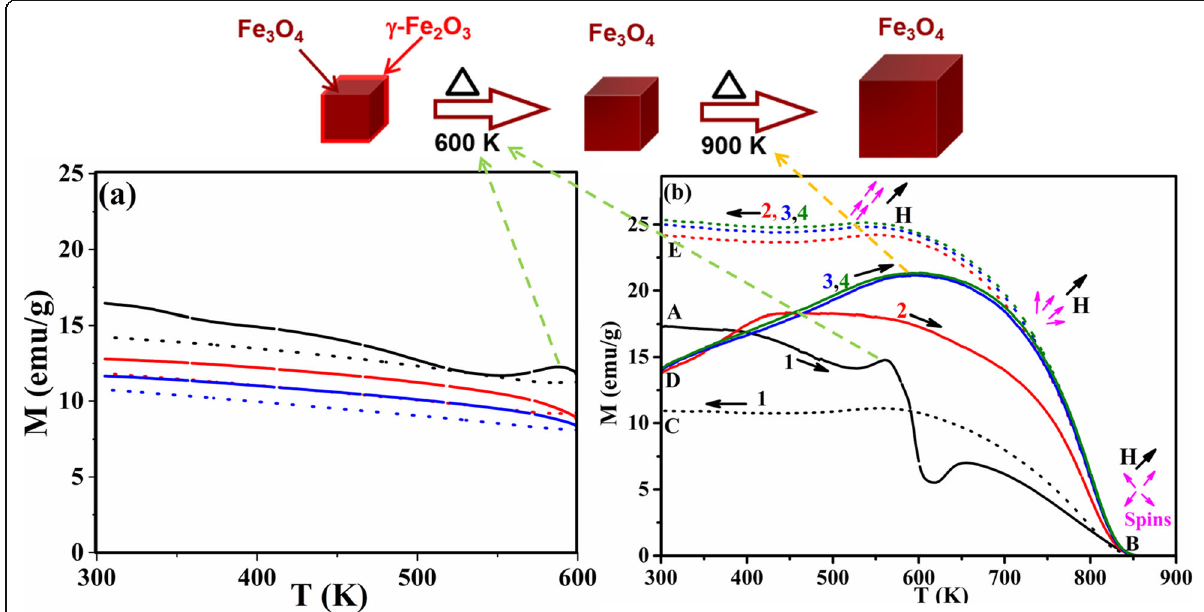
Fig. 9 Change of magnetization ( M ) with temperature ( T ) for pristine Fe 3 O 4 while heating up to a 600 K and b 900 K using magnetic field of 200 Oe at three heating – cooling cycles. The schematic diagram on top of the figure represents the change of morphology of the NPs as temperature increases from 300 to 900 K (Initially, the Fe 3 O 4 NPs are covered with a thin surface layer of γ -Fe 2 O 3 which acts as a shell. Upon heating to 600 K, the γ -Fe